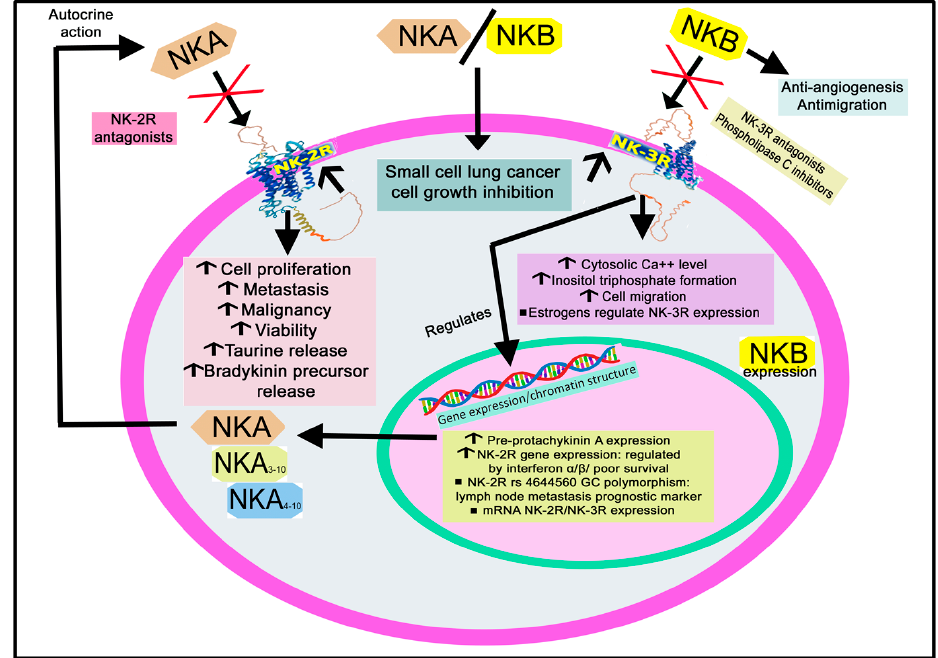
Figure 13. Summary of the mechanisms mediated by NKA/NKB via NK-2R/NK-3R in tumor cells. NKA: neurokinin A; NKB: neurokinin B; NK-2R: neurokinin-2 receptor; NK-3R: neurokinin-3 receptor. ↑ : increase; ↓ : decrease.